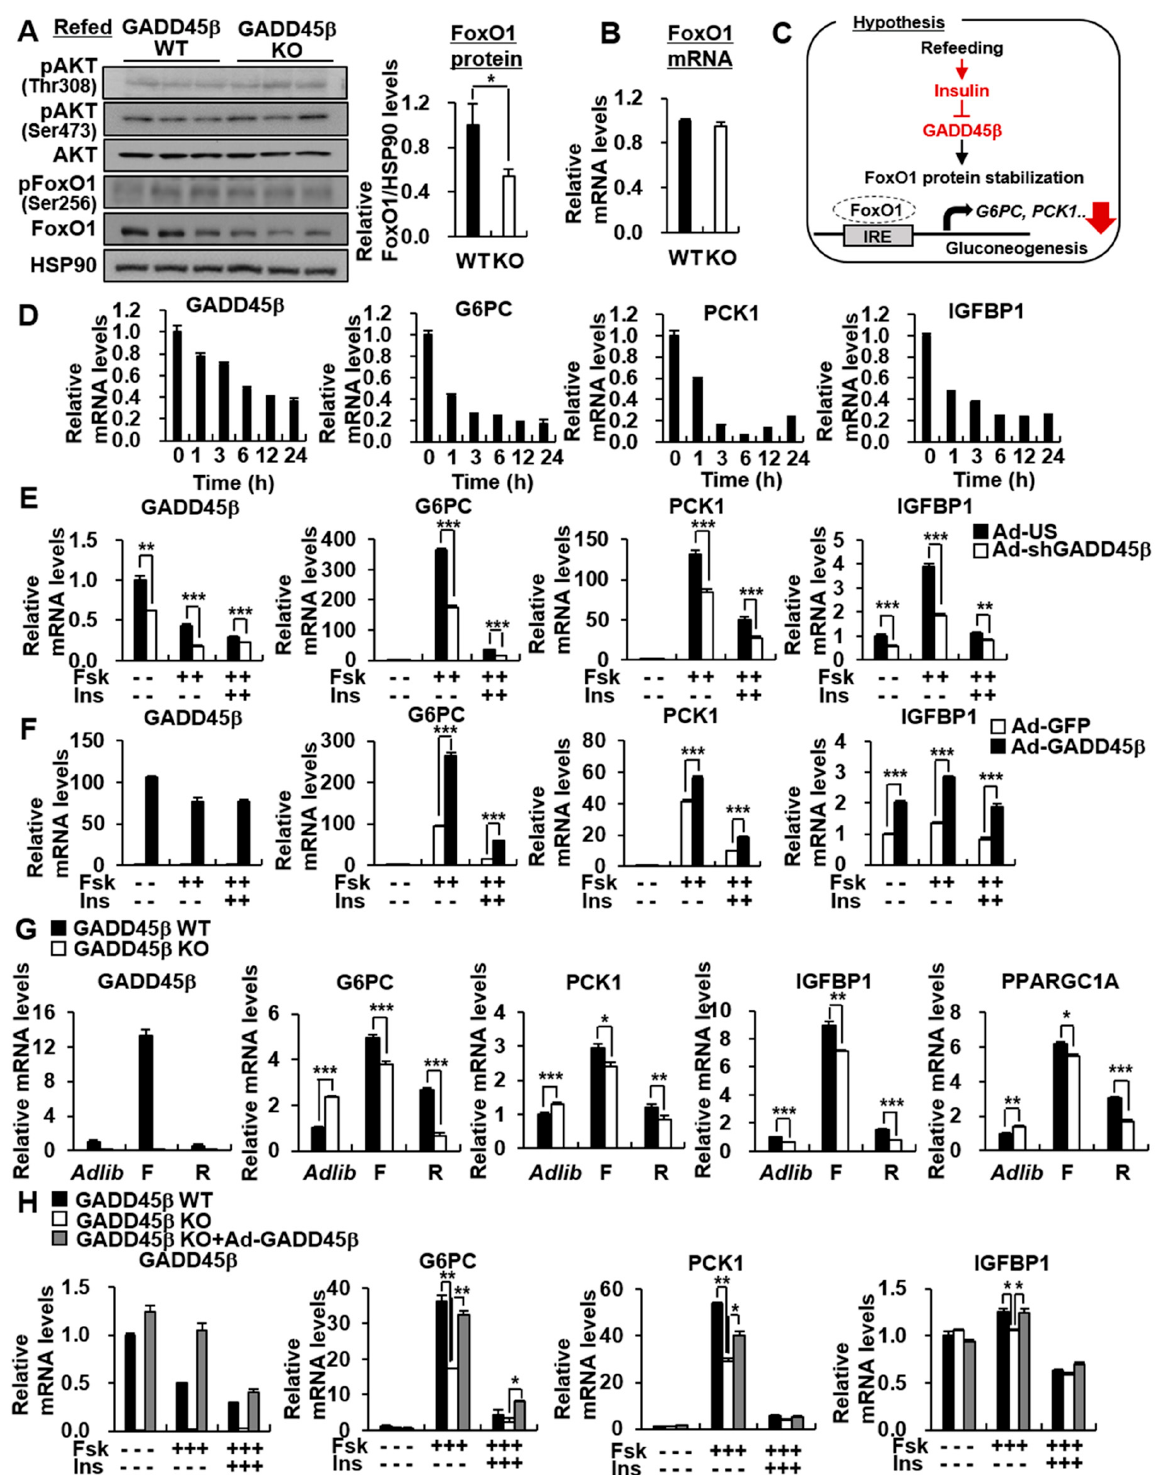
Figure 4. GADD45 β deficiency potentiates insulin-mediated suppression of hepatic gluconeogenesis under refeeding conditions. ( A , B ) GADD45 β WT and GADD45 β KO were refed for 24 h after a 24 h fast. ( A ) Western blot analysis showing the effects of GADD45 β KO on phospho- and total-protein levels of AKT and FoxO1 in the liver ( left ). Bar graph showing the ratio of FoxO1 to HSP90 quantified by ImageJ ( right ). ( B ) qPCR analysis showing FoxO1 mRNA level in the liver. ( C ) A schematic diagram showing hypothesis for the role of hepatic GADD45 β in regulation of hepatic gluconeogenesis under refeeding conditions. ( D ) qPCR analysis showing the effects of insulin on GADD45 β , G6PC, PCK1, and IGFBP1 mRNA levels. Mouse primary hepatocytes were treated with 100 nM insulin (Ins) at times indicated. ( E ) qPCR analysis showing the effects of GADD45 β knockdown on GADD45 β , G6PC, PCK1, and IGFBP1 mRNA levels. Mouse primary hepatocytes infected with Ad-US or Ad-shGADD45 β were treated with or without 10 uM Fsk for 2 h and 100 nM Ins for 24 h. ( F ) qPCR analysis showing the effects of GADD45 β overexpression on GADD45 β , G6PC, PCK1, and IGFBP1 mRNA levels. Mouse primary hepatocytes infected with Ad-GFP or Ad-GADD45 β were treated with or without 1 uM Fsk for 2 h and 10 nM